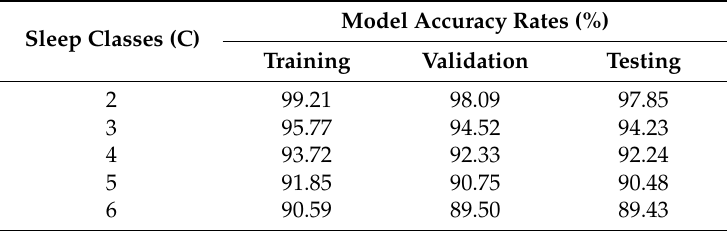
Table 10. Performance values achieved by the proposed models for two to six classes using the sleep-edfx database with a single-channel EEG signal.